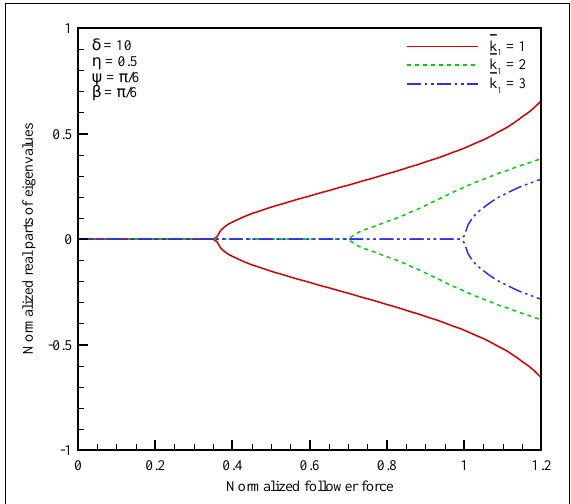
Figure 14. Normalized real part of the eigenvalues vs. normalized distributed follower force [32].